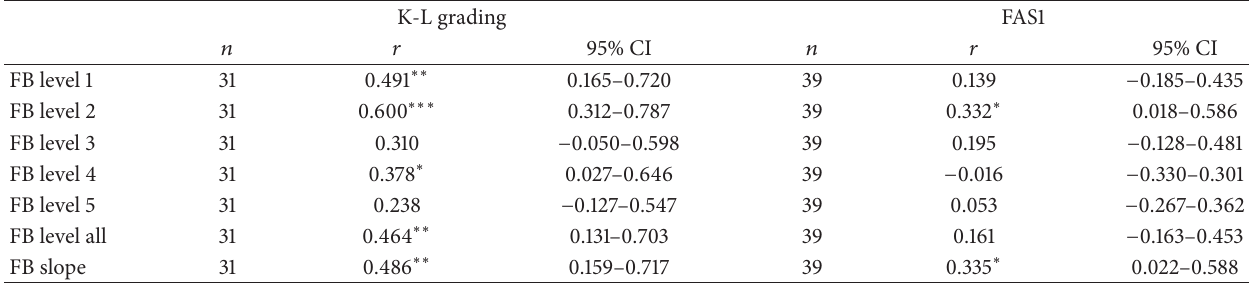
Table 2: Spearman’s rank correlations ( 𝑟 ) between ultrasound femoral (FB) bone depth level intensities and intensity slope and radiographic K-L grading or femoral arthroscopic scoring 1 (FAS1).